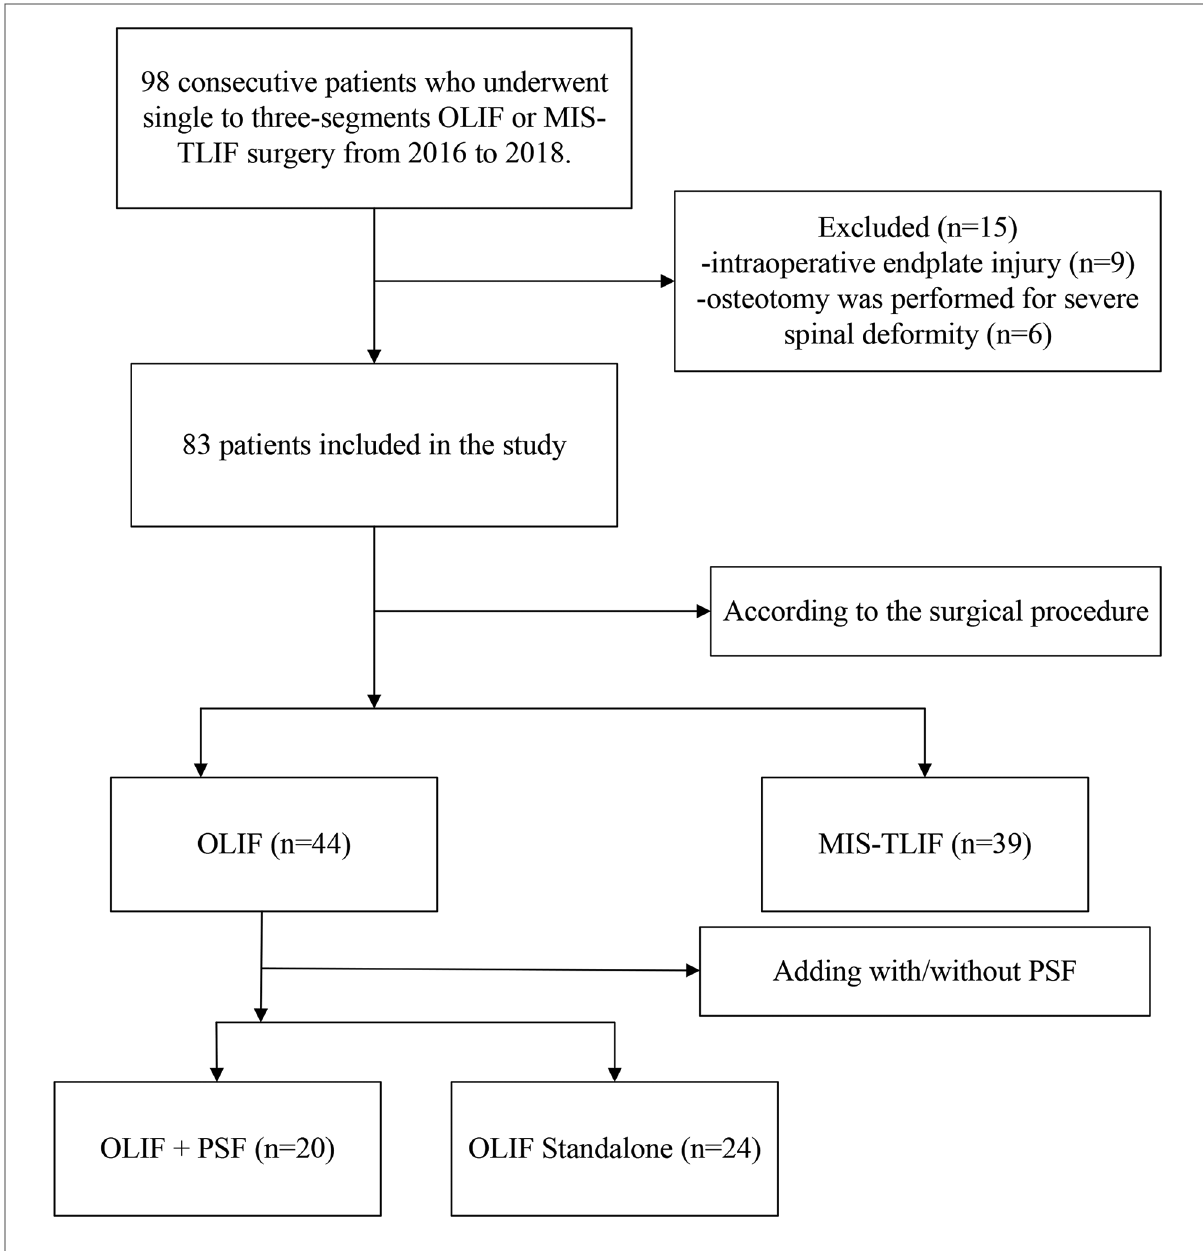
FIGURE 1 A fl owchart of patients included in the